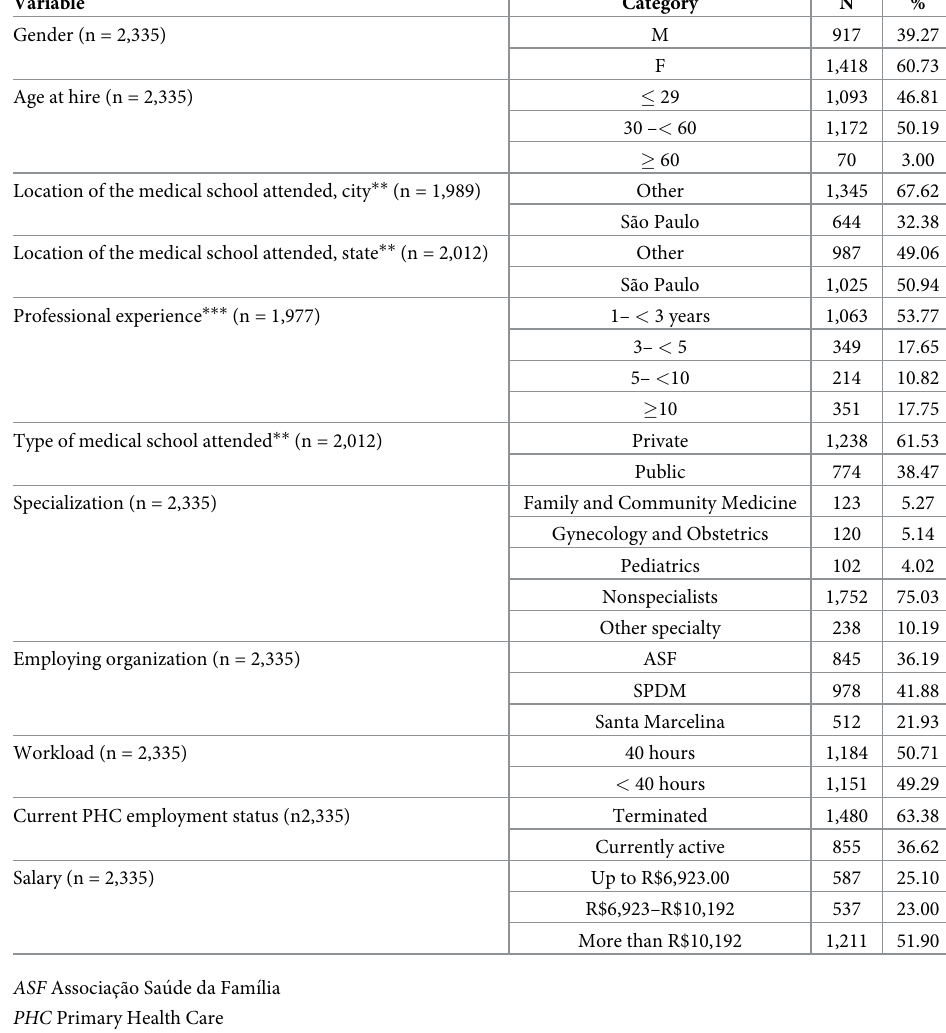
Table 2. Distribution of physician characteristics in the study (n =